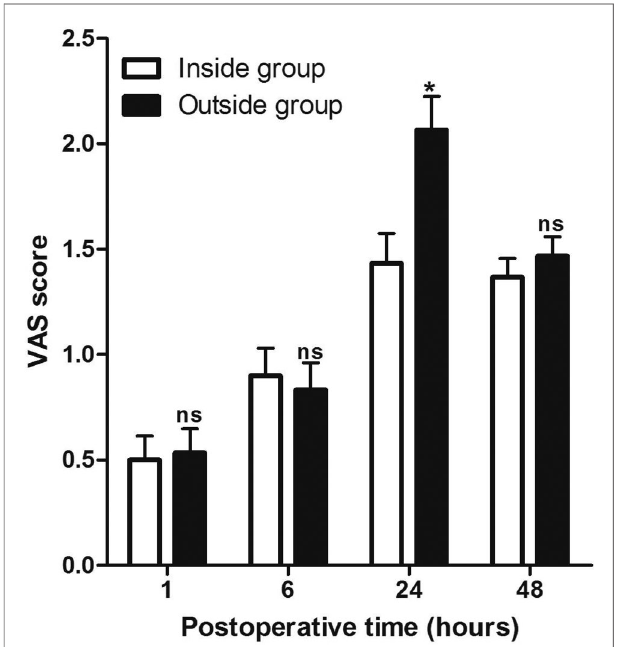
FIGURE 1 | Comparison of visual analogue scale scores at different postoperative times between two groups. Compared with the Inside group, ns p >0.05 and * p <0.05.